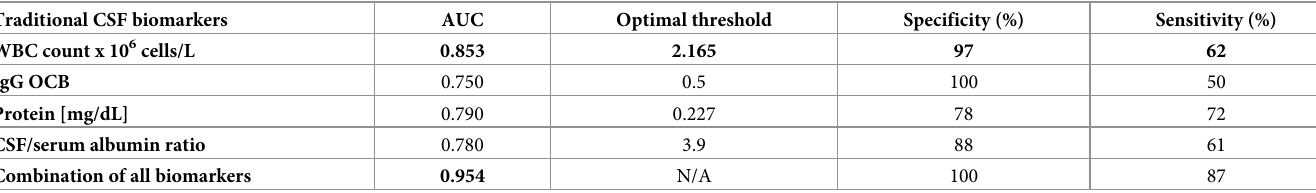
Table 3. Clinical utility of traditional biomarkers for the recognition of neuroinflammation in CSF. Traditional CSF biomarkers